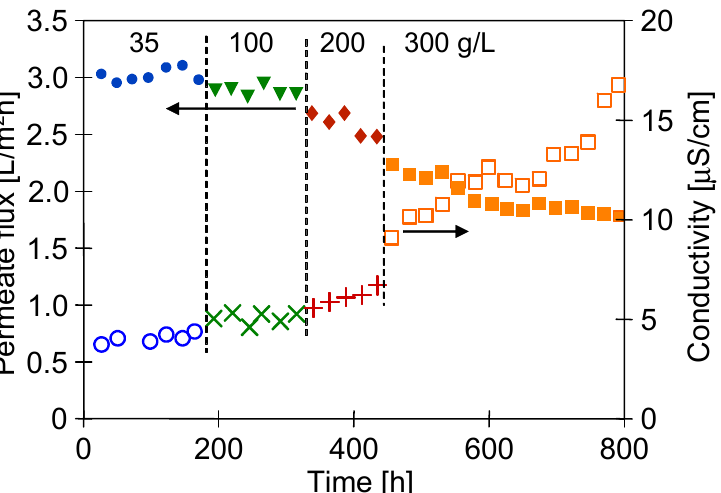
Figure 12. Changes in the permeate flux and distillate conductivity during the MD process of NaCl solutions (35–300 g/L). T F = 60 °C, module M#1.